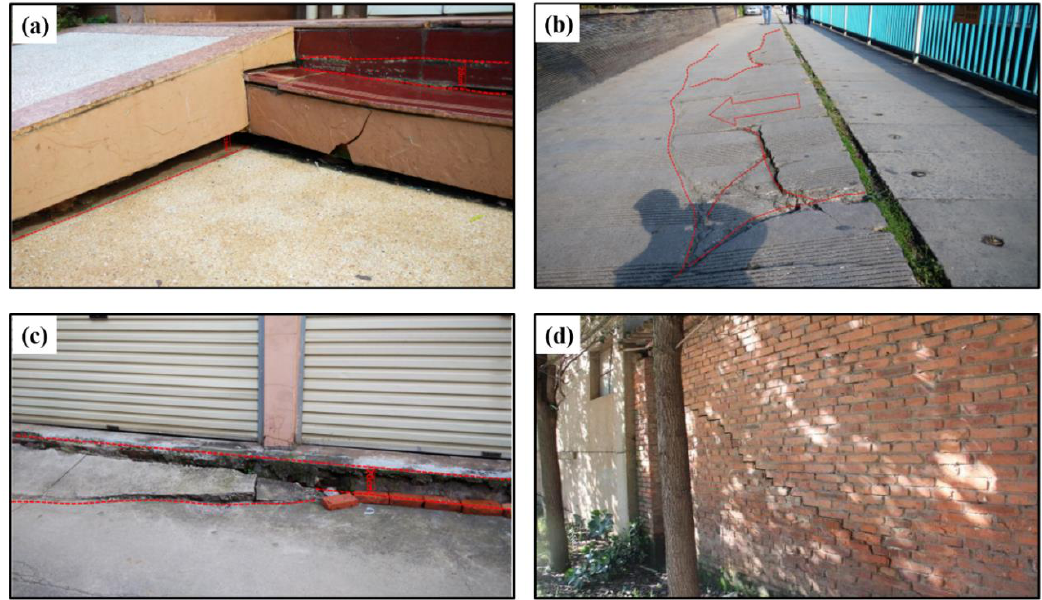
Figure 1. Ground deformation investigated in Kunming and the effects on buildings and roads [4]. ( a ) the uplift of building steps, ( b ) ground crack, ( c ) ground subsidence, ( d ) wall crack caused by the groud